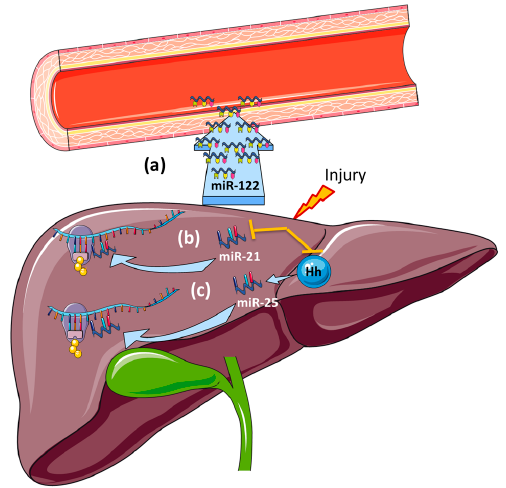
Figure 3. Proposed role of miRNA biomarkers in CFLD. ( a ) After liver injury, hepatocyte death